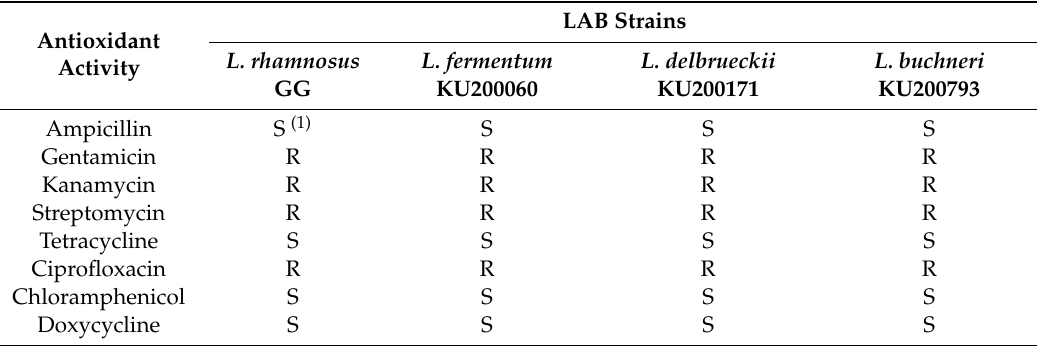
Table 3. Antibiotic resistances of the Lactobacillus strains.